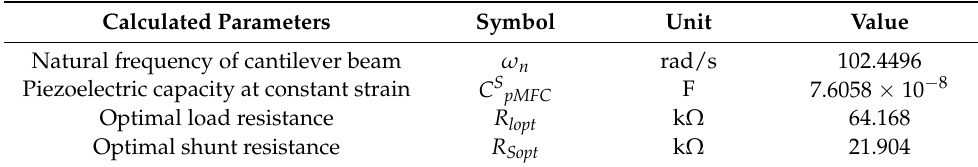
Table 4. Values of calculated parameters of cantilever beam.